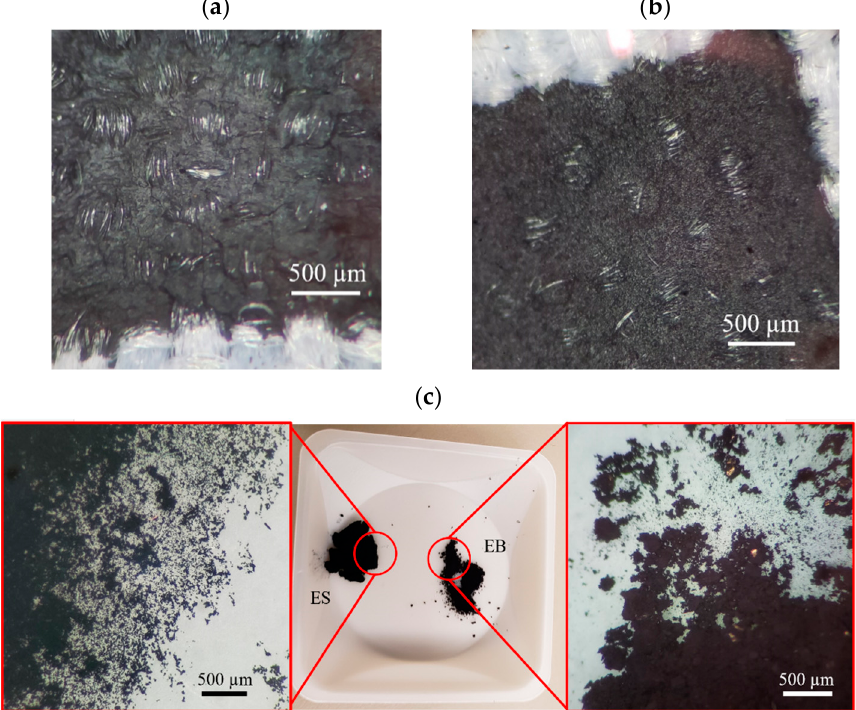
Figure 10. ( a ) PANI-EB + DBSA + Speedball and ( b ) PANI-ES + DBSA + Speedball composites screen- printed on textile substrate showing printing quality. ( c ) Comparison of PANI-ES and PANI-EB particles aggregates, showing much larger PANI-EB aggregates.